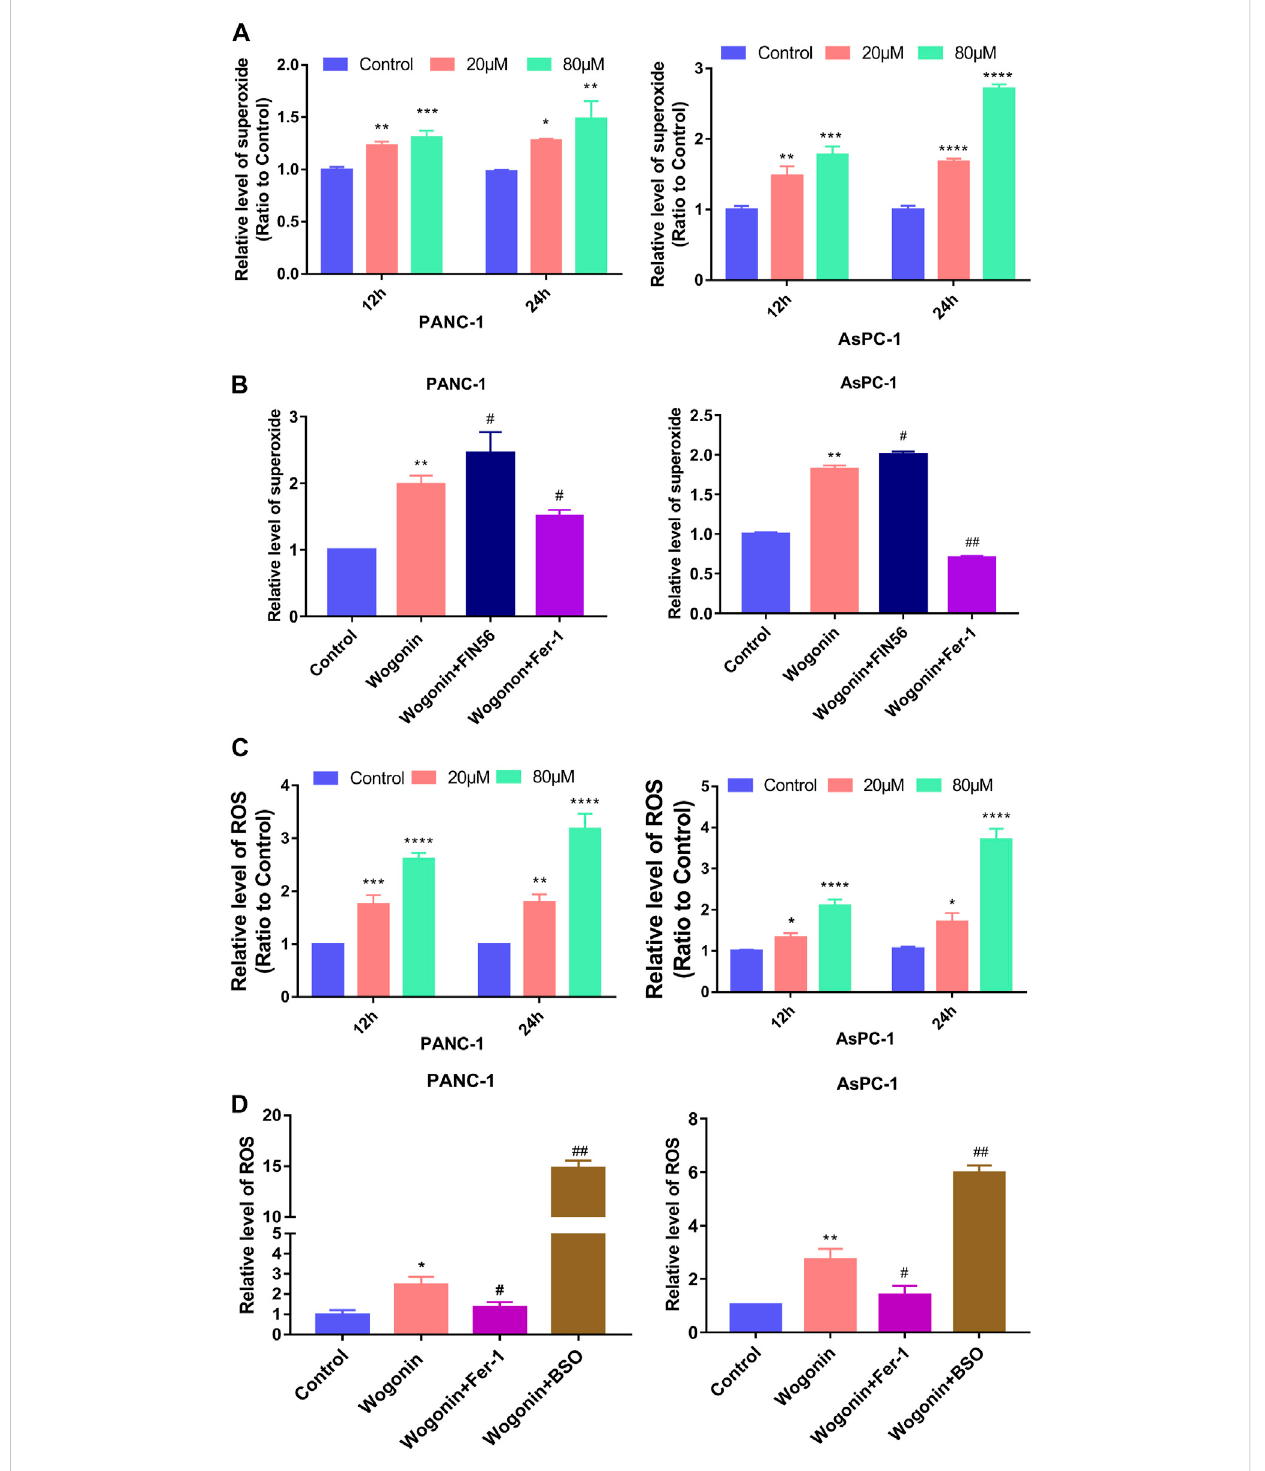
FIGURE 5 Wogonin-inducedaccumulationofsuperoxideandROS. (A) Wogonininducedovergenerationofsuperoxideinpancreaticcancercellsinadosage- and time-dependent manner. (B) Wogonin-induced increase of superoxide was mitigated by fer-1, but was reinforced by FIN56. (C) Wogonin induced accumulation of ROS in pancreatic cancer cells in a dosage- and time-dependent manner. (D) Wogonin-induced accumulation of ROS was alleviated in the presence of Fer-1, but was improved by BSO. * p < 0.05 versus control group; **: p < 0.01 versus control group; ***: p < 0.001 versus control group; ****: p < 0.0001 versus control group; # p < 0.05 versus wogonin-alone group; ### p < 0.001 versus wogonin-alone